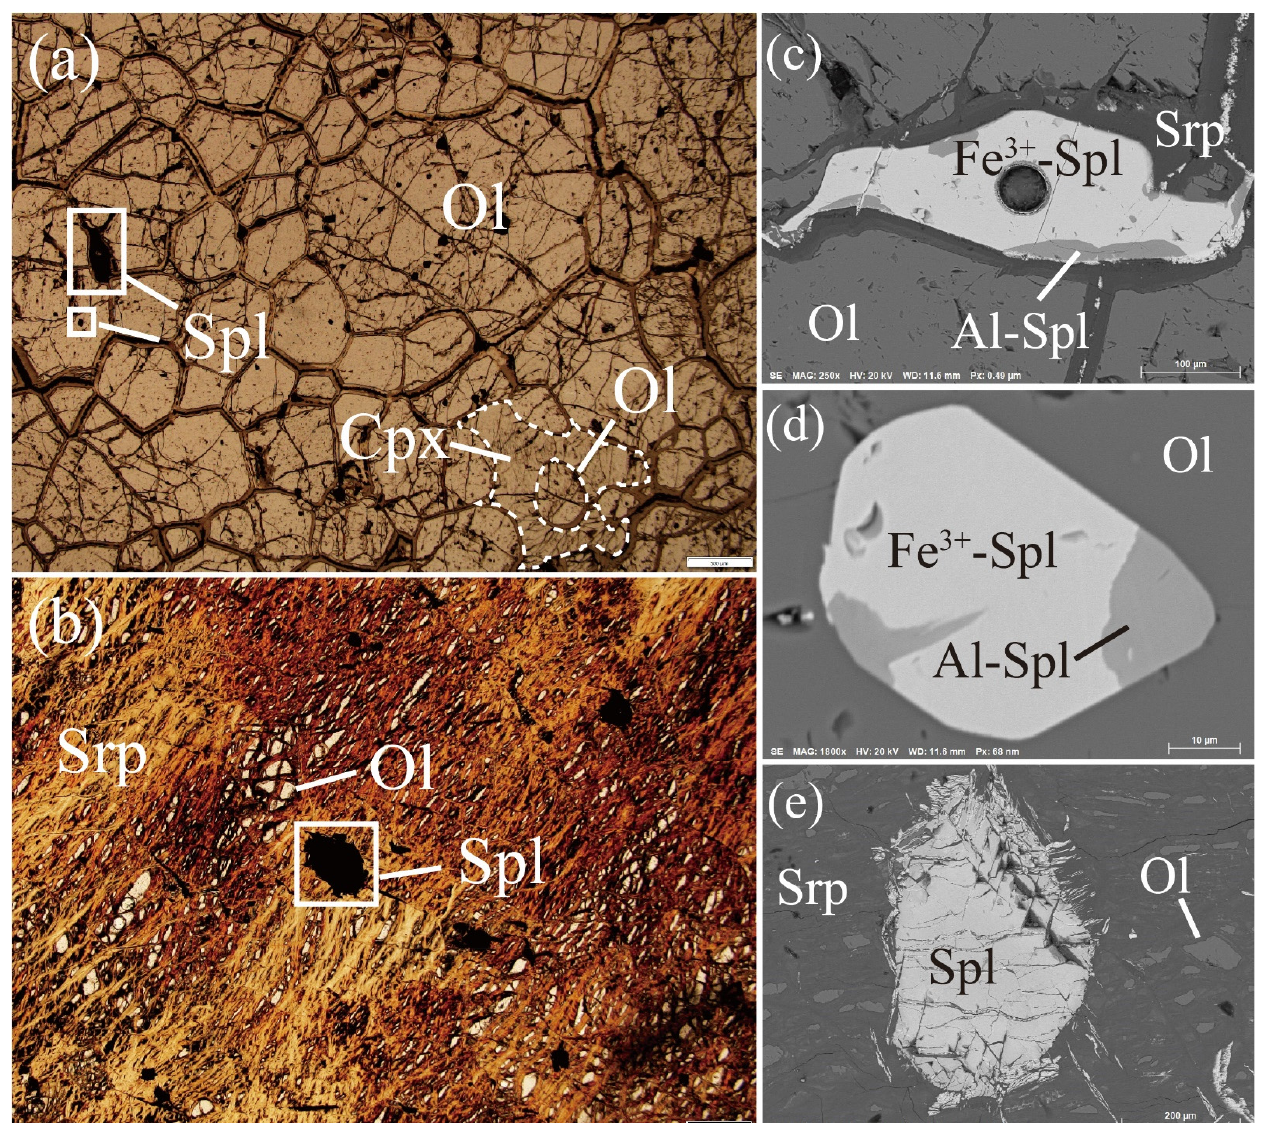
Figure 2. Plane polarized light photomicrographs and back-scattered electron (BSE) images of dunites and wehrlite from the Duke Island complex. ( a ) Accumulate texture of dunite in unaltered sample HC06; ( b ) serpentine and remnant core of olivine in altered sample JH04; ( c ) close up of interstitial anhedral spinel; ( d ) close up of euhedral spinel, which was included in olivine; ( e ) close up of altered spinel. Ol, olivine; Cpx, clinopyroxene; Srp, serpentine; Fe 3+ -Spl, Fe 3+ -rich spinel; Al-Spl, Al-rich spinel.